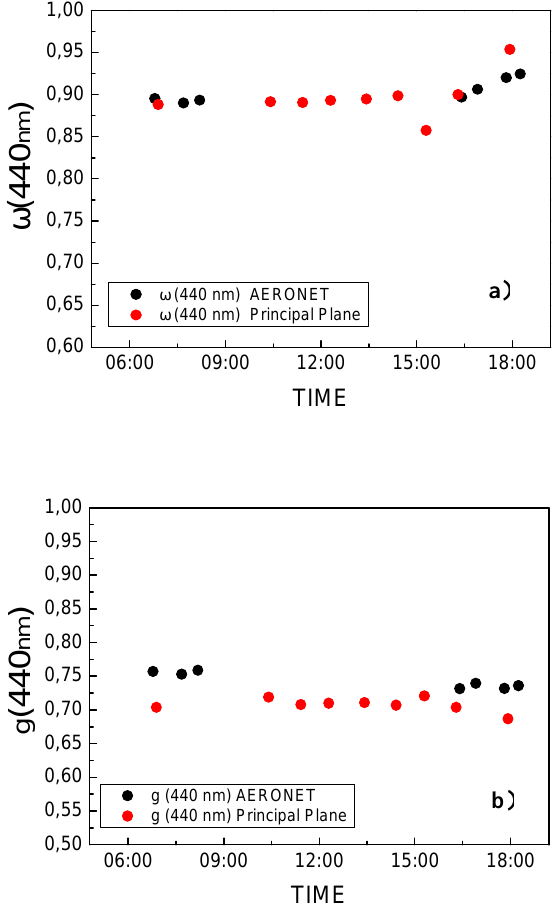
Fig. 3. (a) ω (440nm) and (b) g(440nm) evolutions derived by AERONET code (Level 2.0 data) and by the Principal plane inver- sion code at Granada (23 June